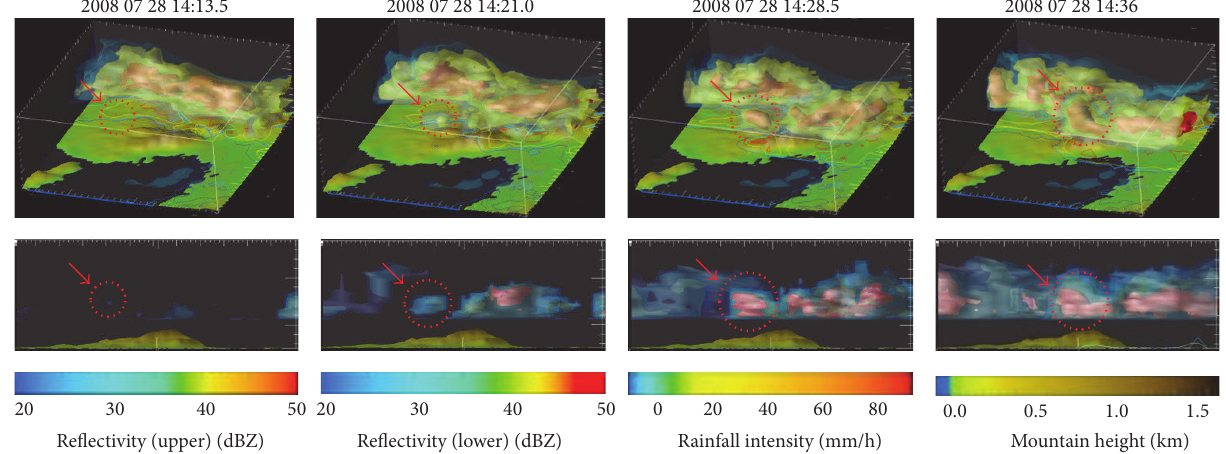
Figure 3: Three-dimensional reflectivity detected by the Miyama C-band radar operated by the MLIT. Contour lines of rainfall intensity are described on the ground. Toga River is located at the center of each figure.